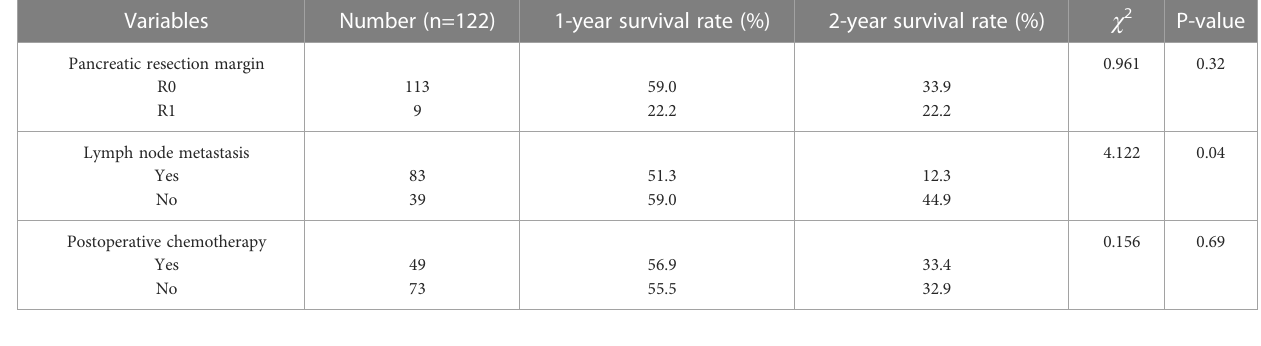
TABLE 5 Multivariate analysis of long-term survival in patients with BRCP.